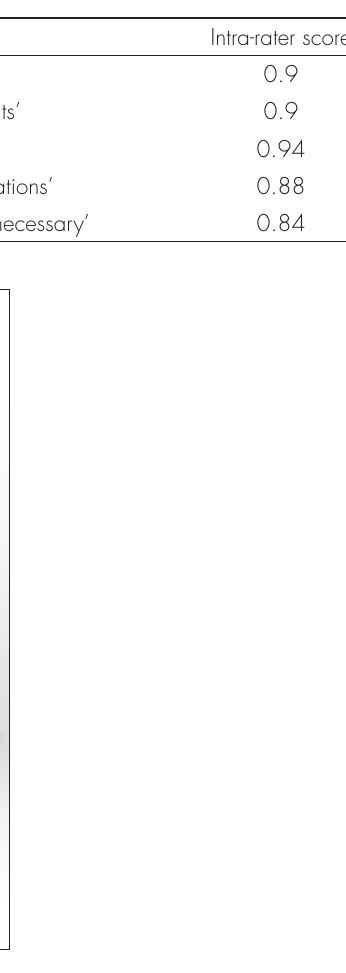
Figure 2. % distribution of specialist orthodontic practice Facebook pages in each ‘non-compliant’ domain (N=147).